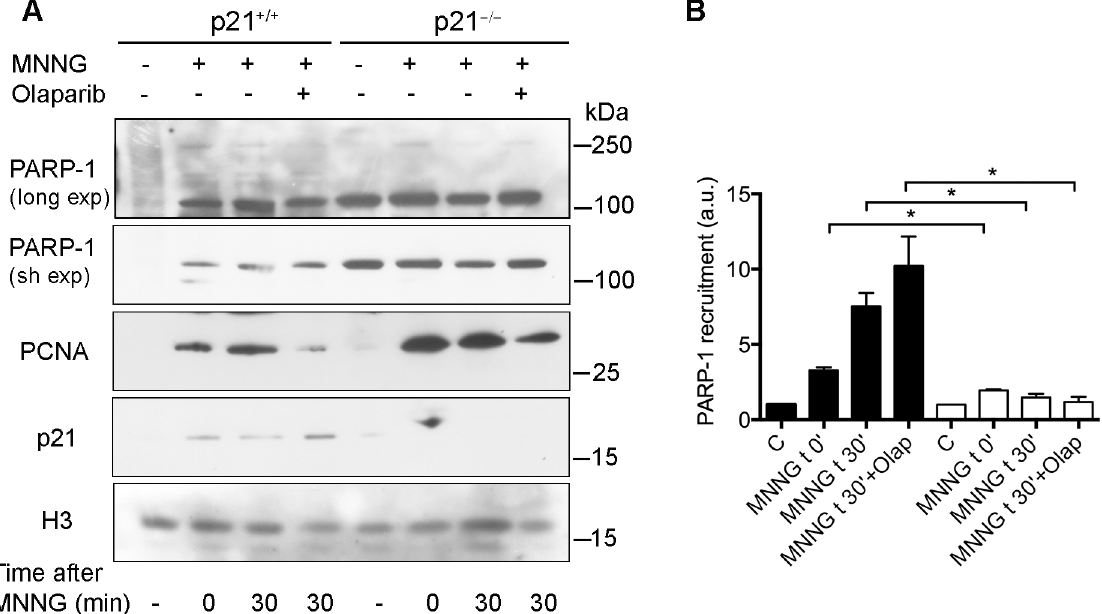
Fig 5. Reduced chromatin-binding of PARP-1 after DNA damage in p21 − / − fibroblasts. ( A ) Human p21 +/+ and p21 − / − fibroblasts were treated with 25 μ M MNNG and then collected immediately (t 0), or after 30 min recovery (t 30), in the absence or in the presence of 10 μ M Olaparib. Chromatin-bound fractions were extracted and analysed by Western blot for PARP-1 after long and short (sh) film exposure (exp), and for PCNA, p21 or histone H3 (loading control). ( B ) Densitometric analysis of PARP-1 recruitment, compared to the untreated samples, after normalization to histone H3 content. Results are mean values ± S. D. of three independent experiments ( * , P < 0.05, t-test).